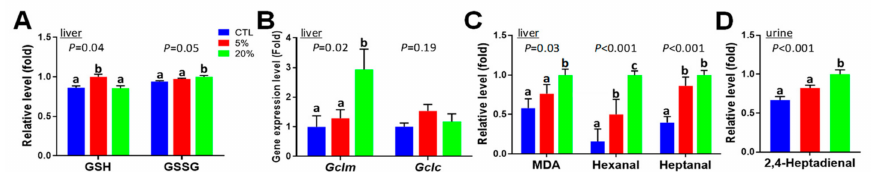
Figure 7. E ff ects of Scenedesmus feeding on hepatic and urinary metabolites associated with redox status. ( A ) Reduced glutathione (GSH) and oxidized glutathione (GSSG) in the liver. ( B ) Expression levels of Gclm and Gclc genes in the liver. The control is artificially set as 1. ( C ) Aldehydic lipid oxidation products (LOPs) in the liver. ( D ) 2,4-Heptadienal in urine. P -values indicate overall significances across all sample groups from the one-way ANOVA test. Means with di ff erent letter labels (a,b,c) indicate